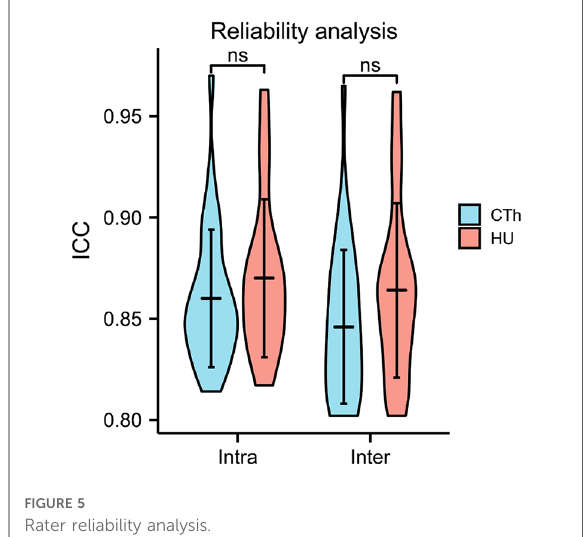
FIGURE 5 Rater reliability